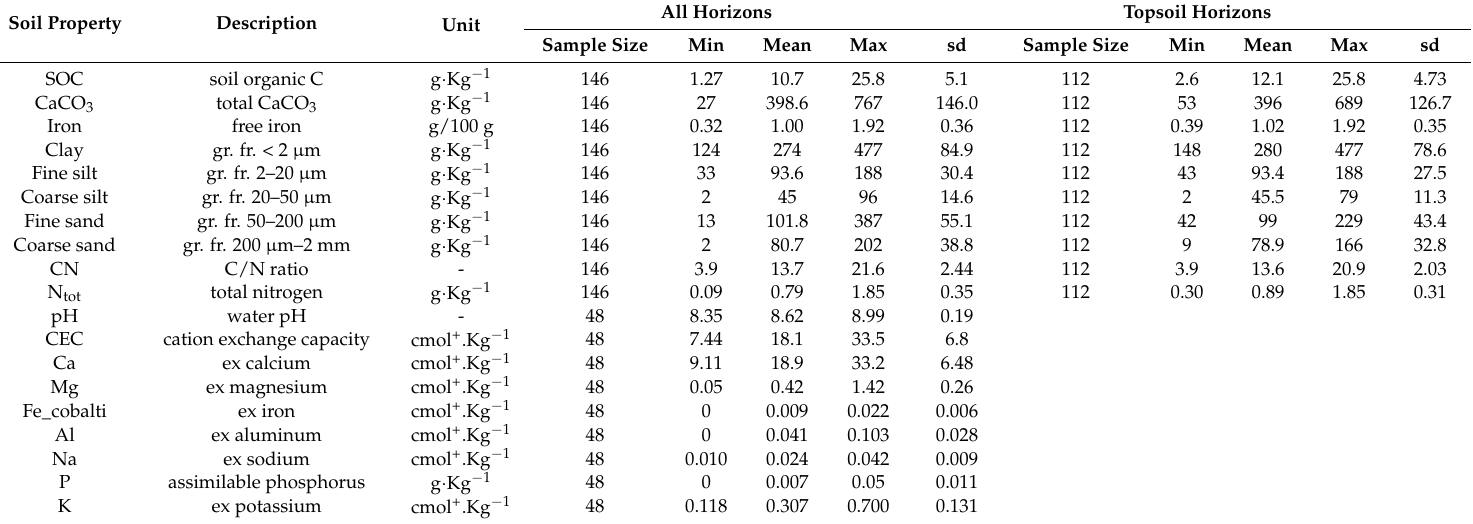
Table 3. Dataset used in the modeling and statistics on soil properties for either all depth horizons or topsoil horizons.